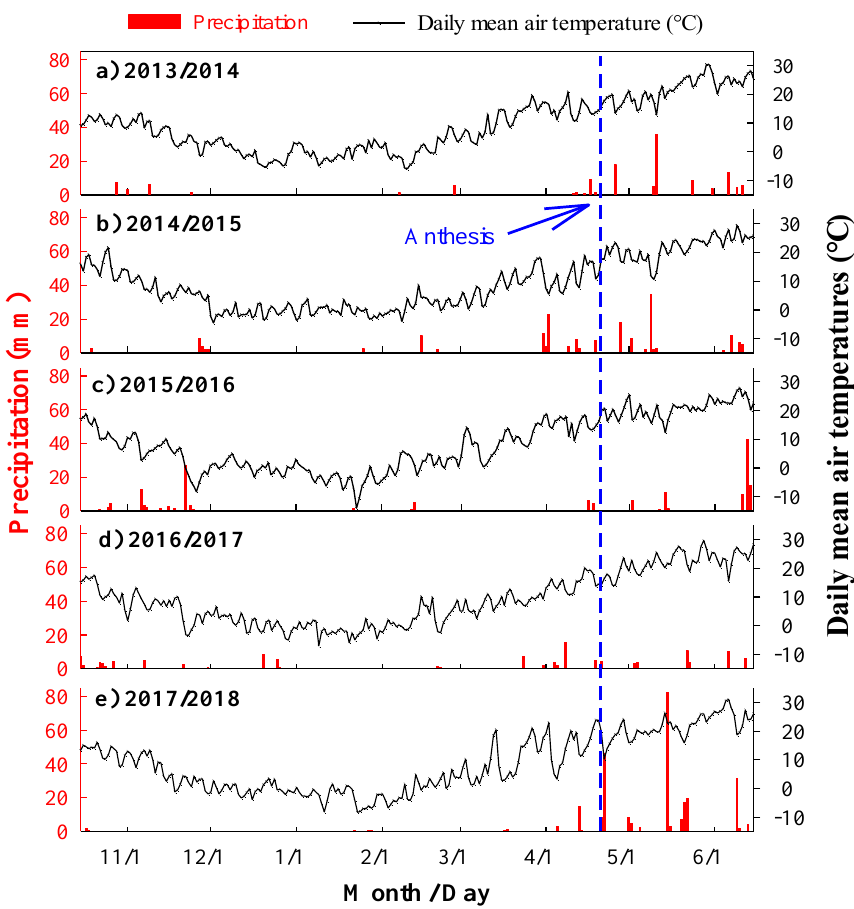
Figure 1. Agrometeorological status of daily precipitation, daily mean air temperature of Wuqiao Experimental Station during the 2013 – 2018 winter wheat growing period in Cangzhou, Hebei, China.